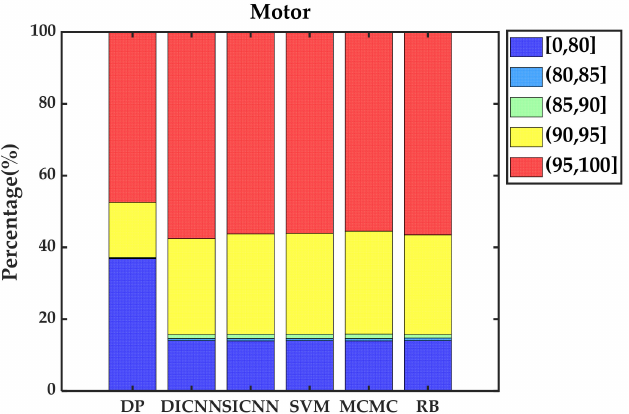
Figure 20. The number of motor operating points in each efficiency